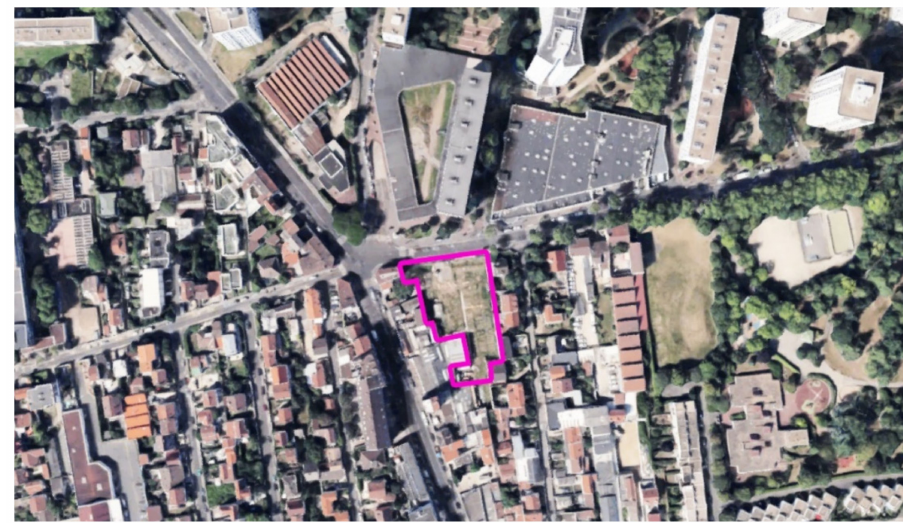
Figure 4. Location of the AgroCit é farm in the Colombes district in Paris, before relocation [original study, based on: www.google.pl/maps, (accessed on 16 August 2018)].